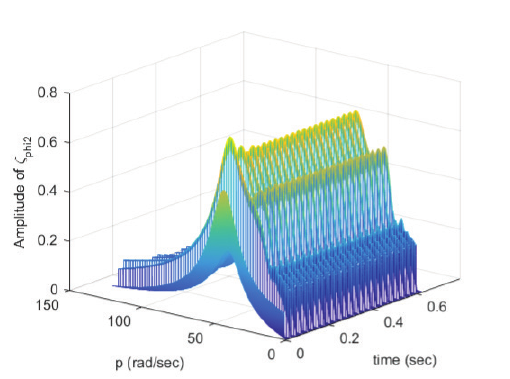
Figure 13. Roll rate eff ect on ti me history of